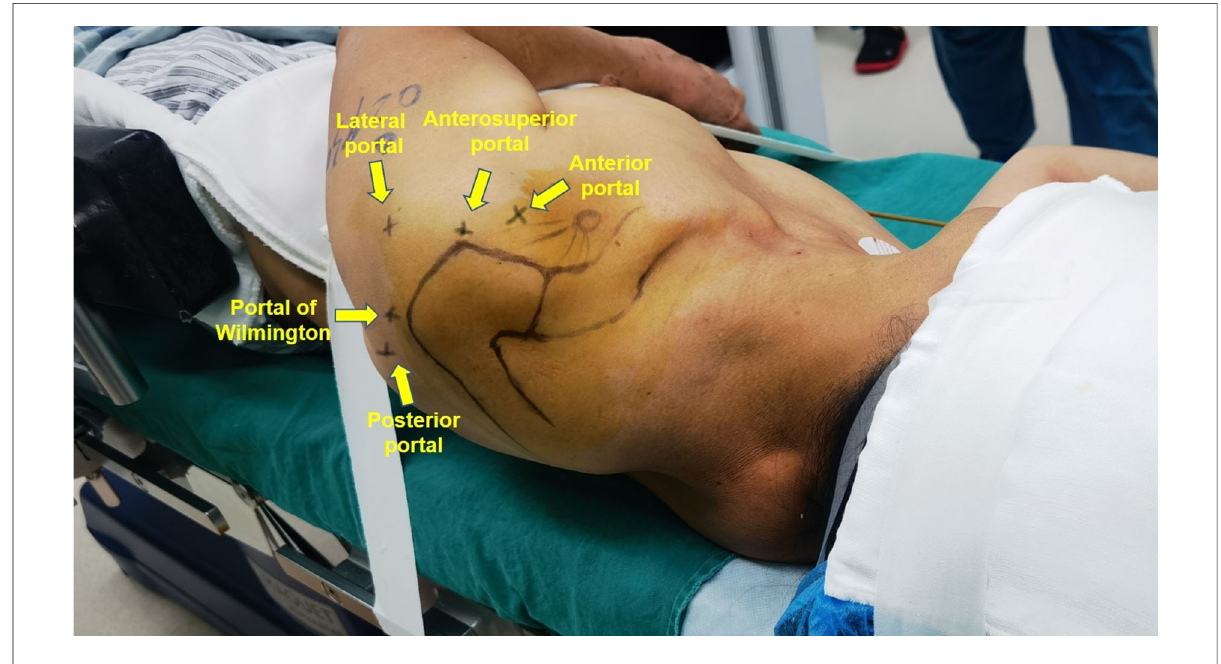
FIGURE 1 The standard anterior portal, lateral portal, posterior portal, anterosuperior portal and, portal of Wilmington had been